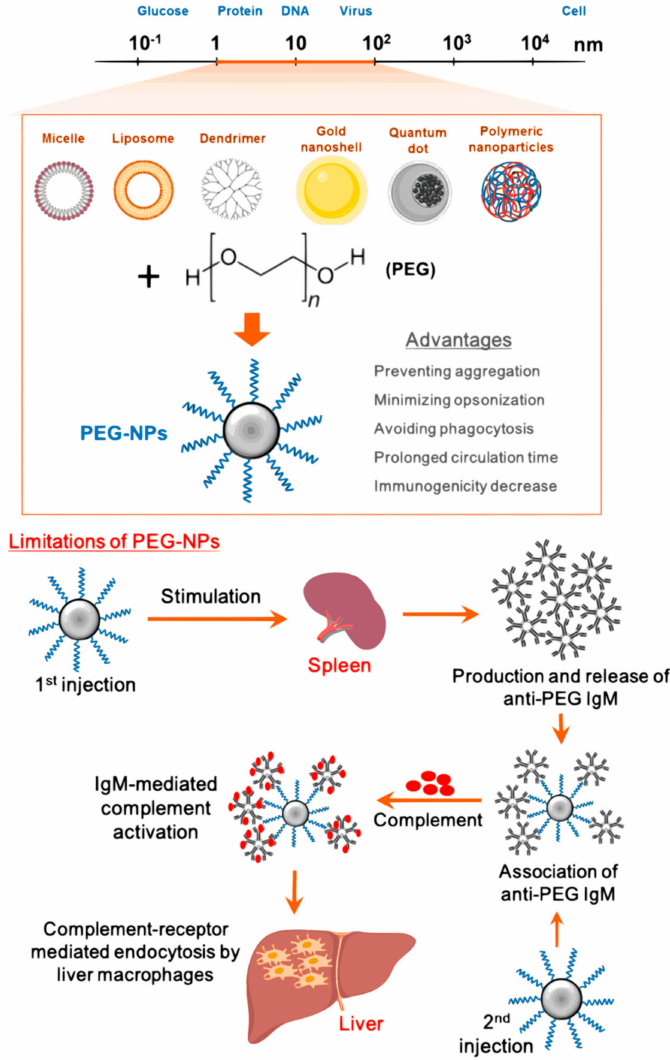
Figure 2. Effect of PEGylation. Polyethylene glycol (PEG) is conjugated to nanoparticles (NPs) surface to form PEG-NPs, providing several advantageous properties within a drug delivery system. The diagram also indicates the limitations associated with PEGylating of nanoparticles. Adapted and modified with permission from [22]. Copyright (2020)